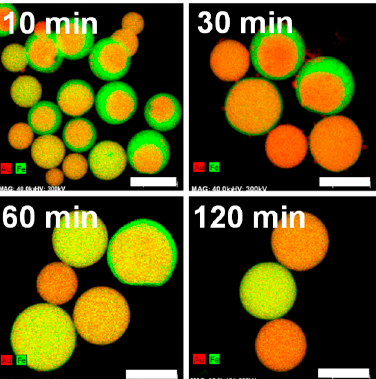
Figure 8. EDS mapping images of particles obtained by different laser irradiation times from the Au50 raw particle solution. Corresponding HAADF-STEM images are shown in Figure S3 in Supporting Information. All scale bars are 500 nm.